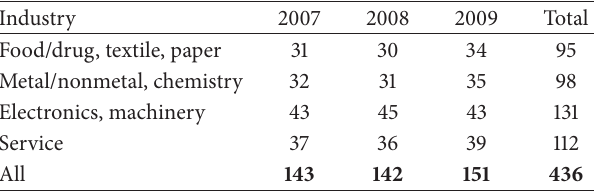
Table 4: Data group categorised by industry.